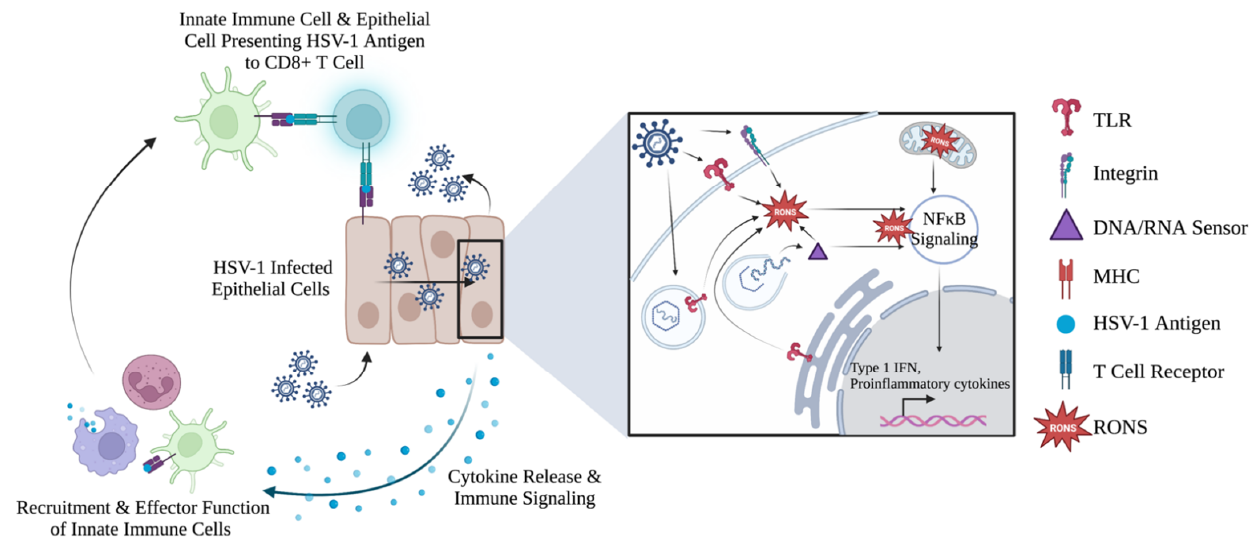
Figure 4. Overview of how cellular immune responses are stimulated during HSV-1 lytic infection. Inside the infected cell, PRRs involving TLRs, DNA/RNA sensors, and integrins sense components of HSV-1. Upon activation of sensors by HSV-1 or HSV-1-induced oxidative stress, immune signal- ing pathways such as NF-κB can be stimulated to promote the expression of proinflammatory cyto- kines. When released by the infected cell, these cytokines aid in innate immune cell (e.g., macro- phage, dendritic cell, neutrophil) recruitment to promote phagocytosis and uptake of HSV-1 anti- gens for presentation to the immune system and stimulation of an adaptive anti-HSV-1 immune response (e.g., CD8+ T cells). Alternatively, epithelial cells can also present CD8+ T cells with HSV- 1 antigens to prompt elimination of the infected